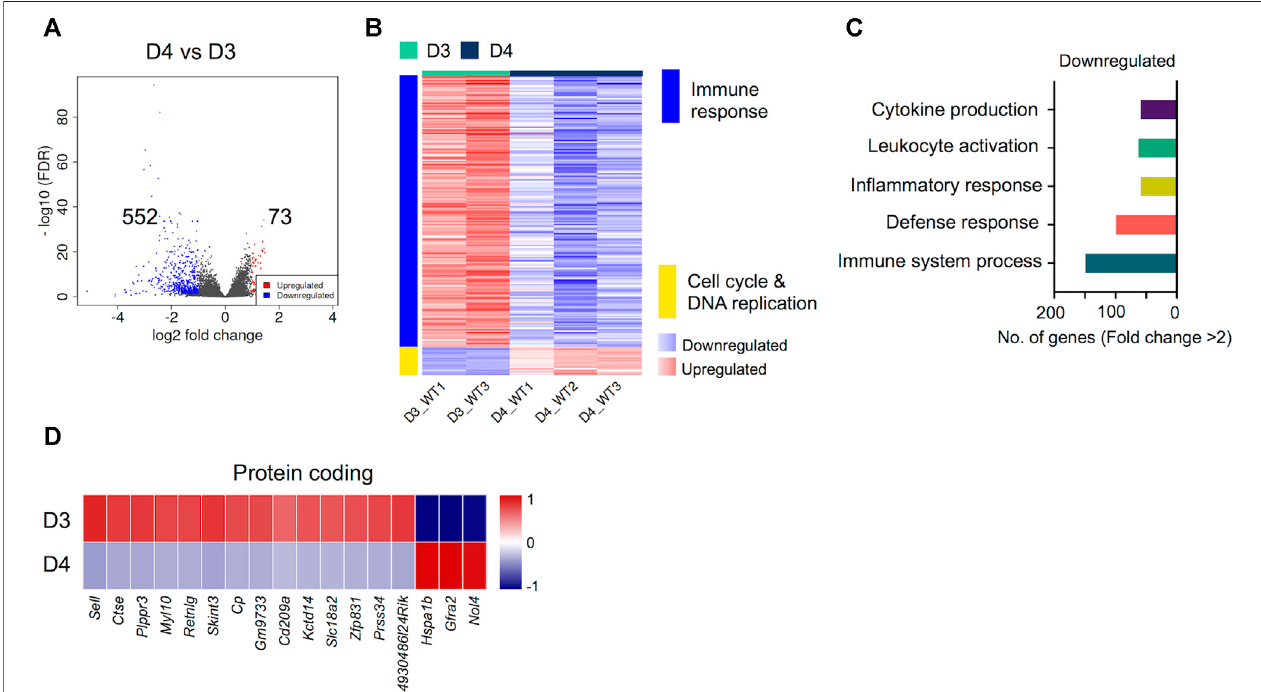
FIGURE4| Differentiallyregulatedgenesinlateosteoclastdifferentiation.Thetranscriptomesoffullydifferentiatedosteoclasts(D4)werecomparedwithosteoclast precursors (D3). (A) Volcano plot represents signi fi cantly upregulated (red), downregulated (blue) or genes with unchanged expression levels (gray) between D4 and D3 comparison. (B) Heatmap shows gene enrichment and associated pathways in D4 versus D3. (C) Bar plot shows the numbers of genes corresponding to signi fi cantly up/downregulated functional pathways from gene ontology enrichment analyses. (D) Heat maps show the gene expression (Z-scores) of downregulated and upregulated protein coding genes in D4 versus D3 comparison.